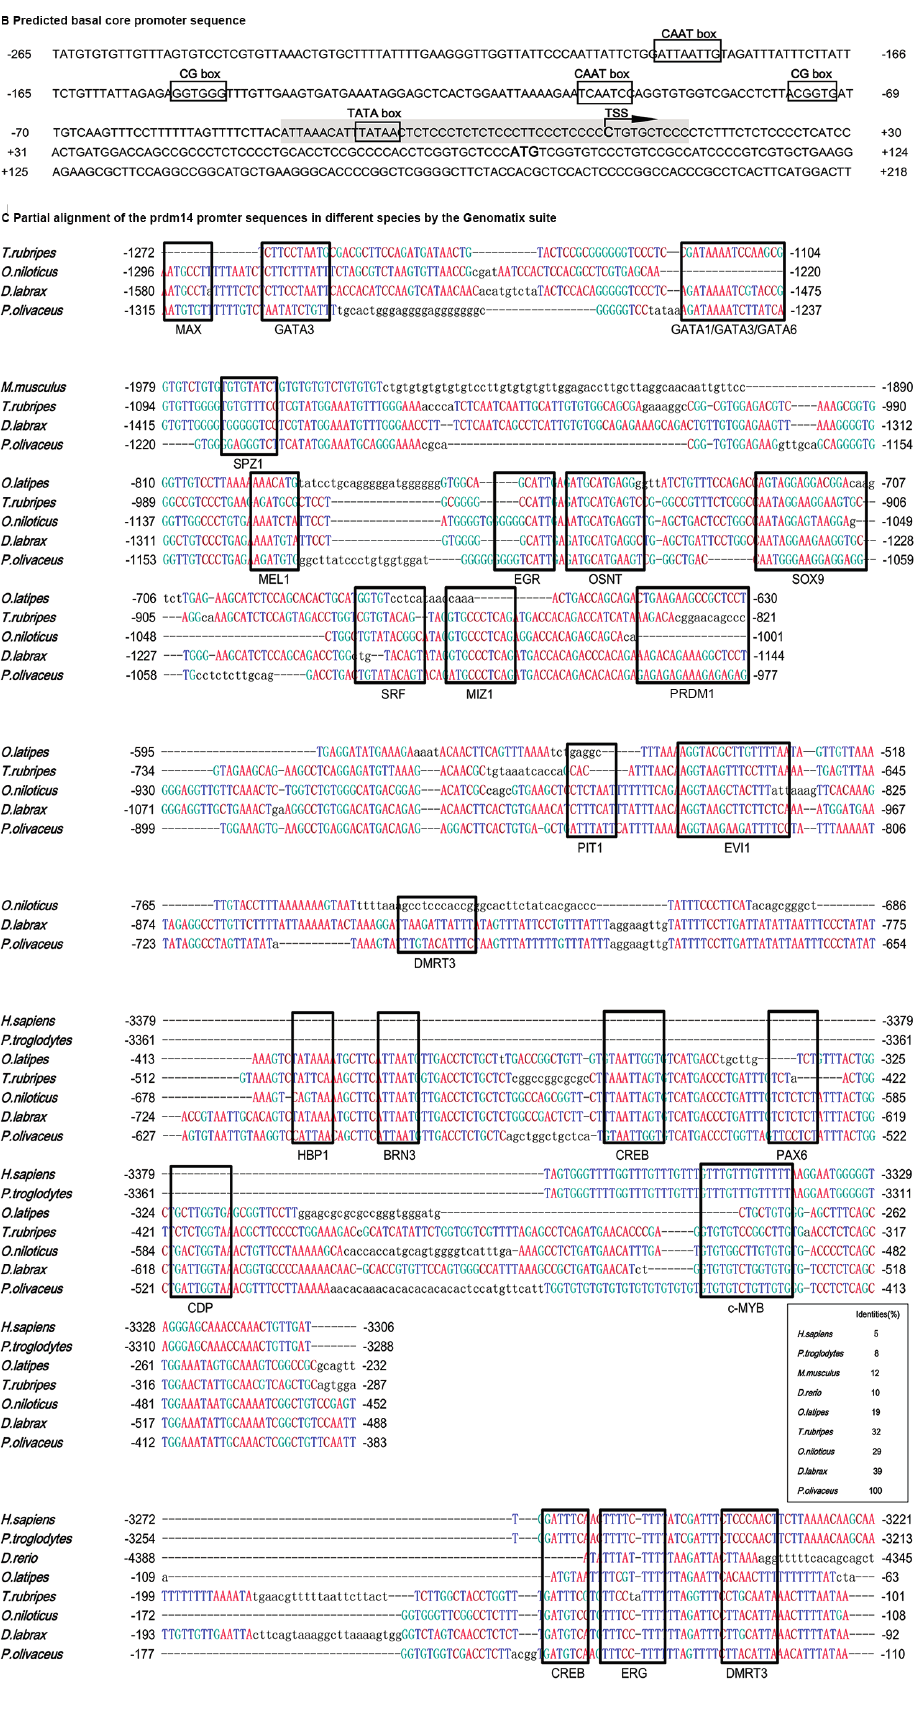
Figure 6. Po-prdm14 promoter sequence features. ( A ) Schematic of the putative regulatory motifs in the Po-prdm14 gene. The potential transcriptional start site (TSS; +1) was